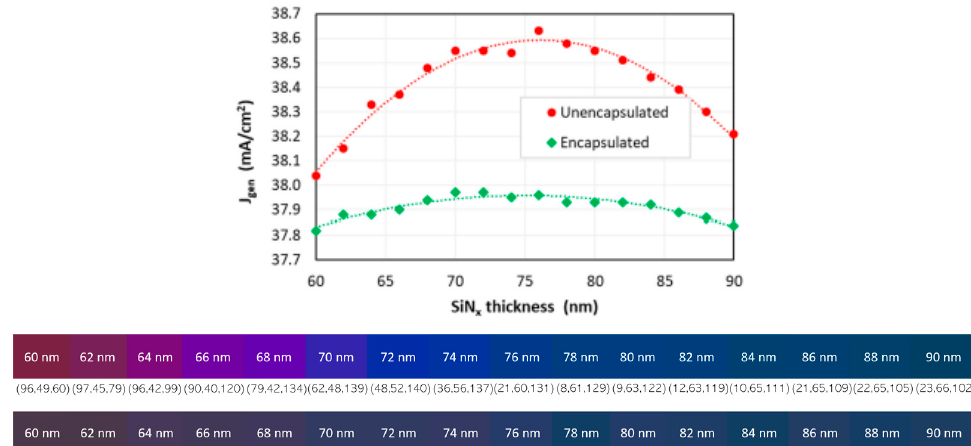
Figure 8. Generated photocurrent ( on the top ) and perceived colour ( on the bottom ) as a function of the SiNx thickness, before and after encapsulation. Reproduced with permission from [47], copyright 2018, AIP Publishing.